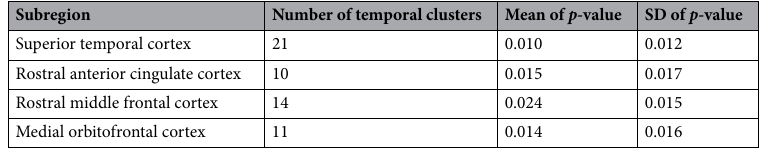
Table 1. Statistics of significant temporal clusters in the comparison between iEEG sampled around note onsets and reference windows within each subregion in all twelve sessions.